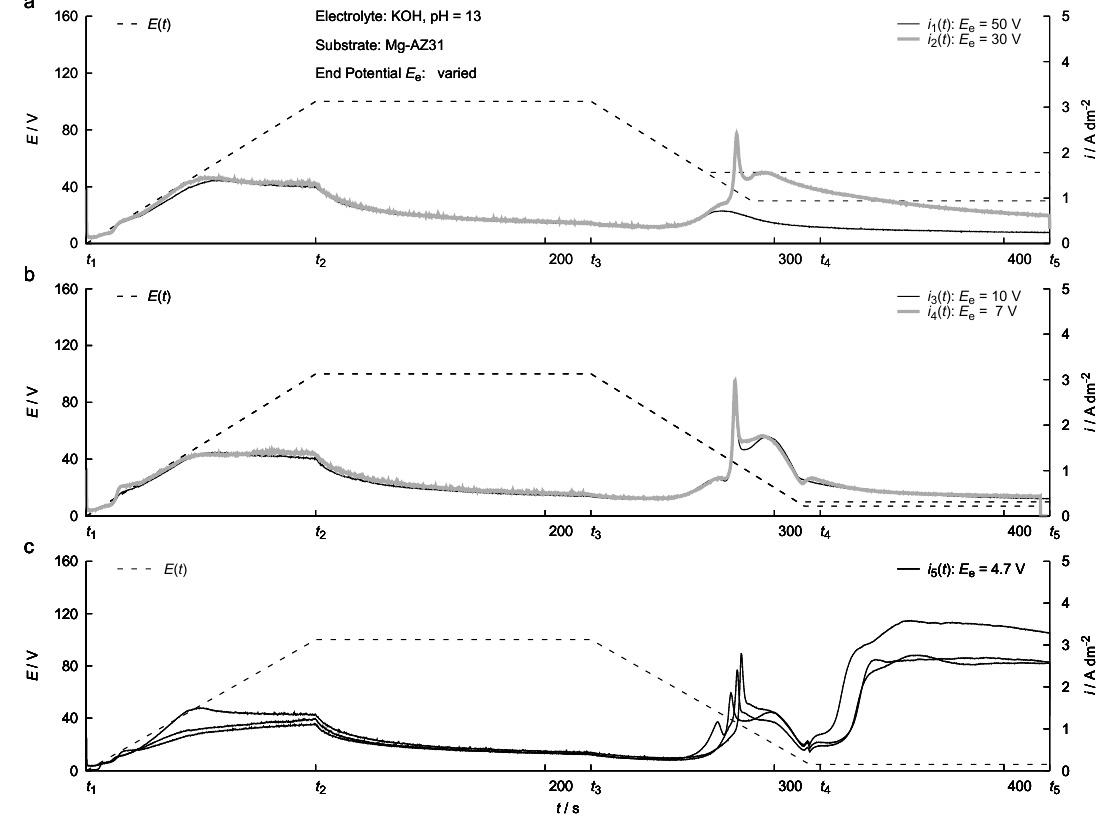
Figure 7. Results of polarisation experiments within KOH solution of pH = 13 on AZ31 with different end potentials U e , for U e = 4.7 V the curves for three repetitions of the measurement are